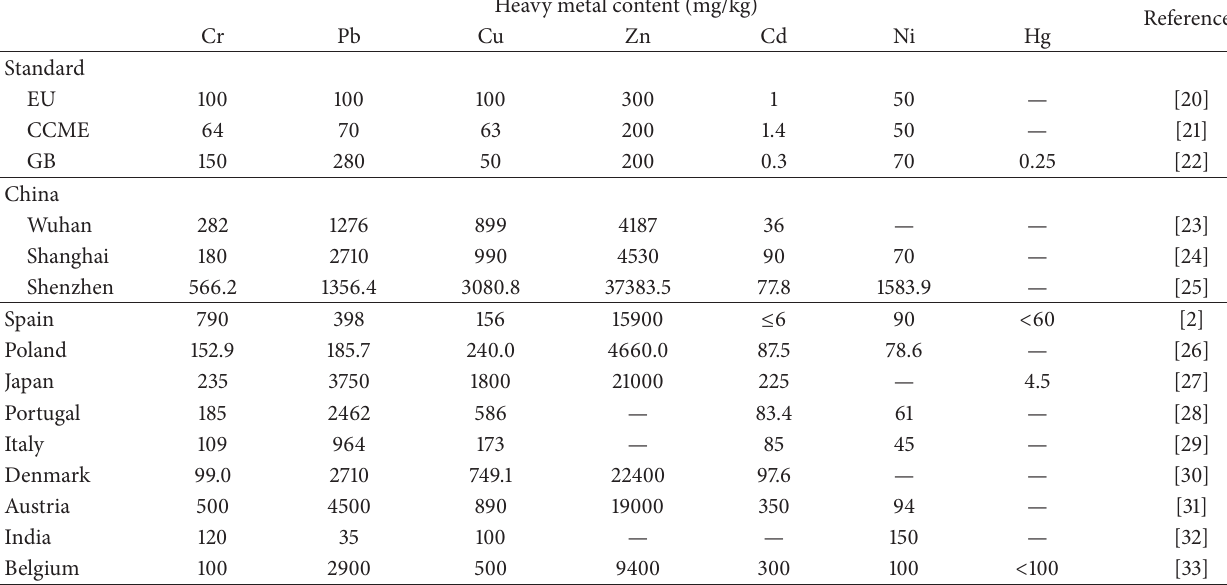
Table 1: Heavy metals in fly ash from various districts and countries. Heavy metal content (mg/kg)